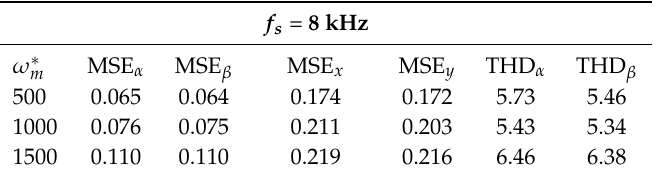
Table 2. Simulation performance test of stator currents ( α - β ), ( x - y ), MSE (A), THD (%) at different rotor speeds (rpm).